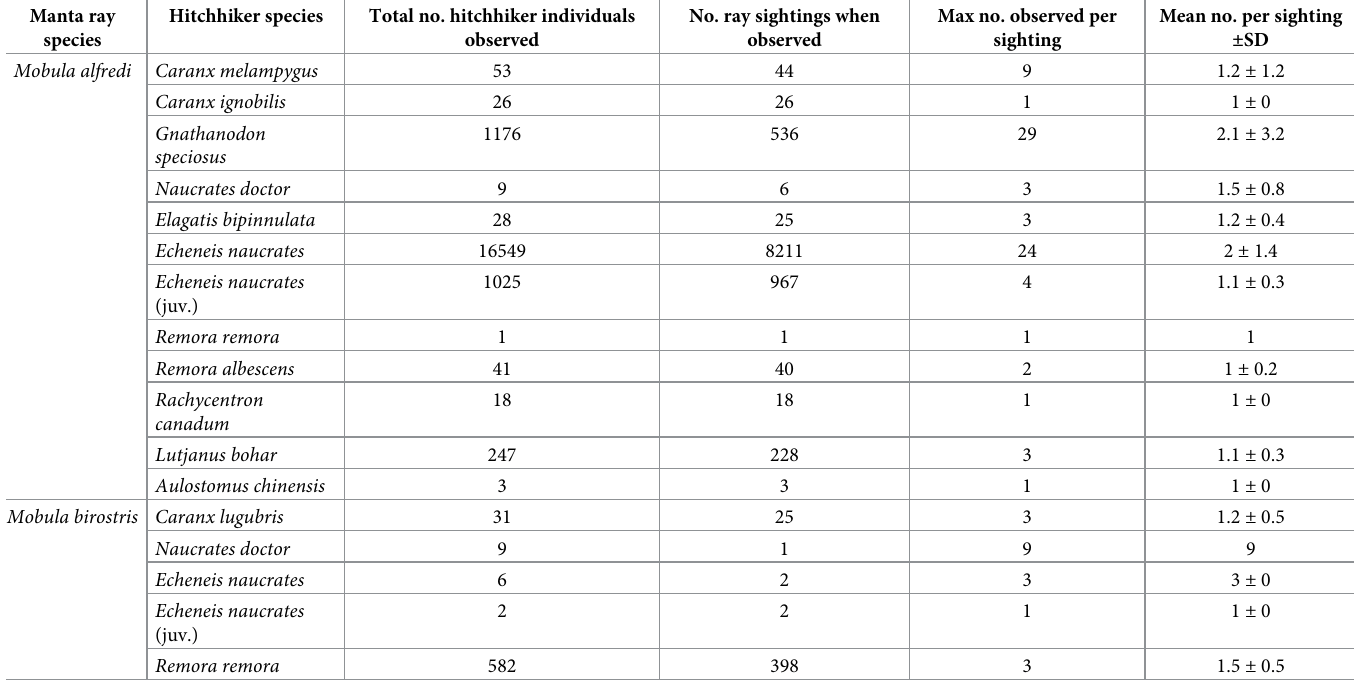
Table 1. Summary of hitchhiker species observed with manta rays. Manta ray Hitchhiker species Total no. hitchhiker individuals species